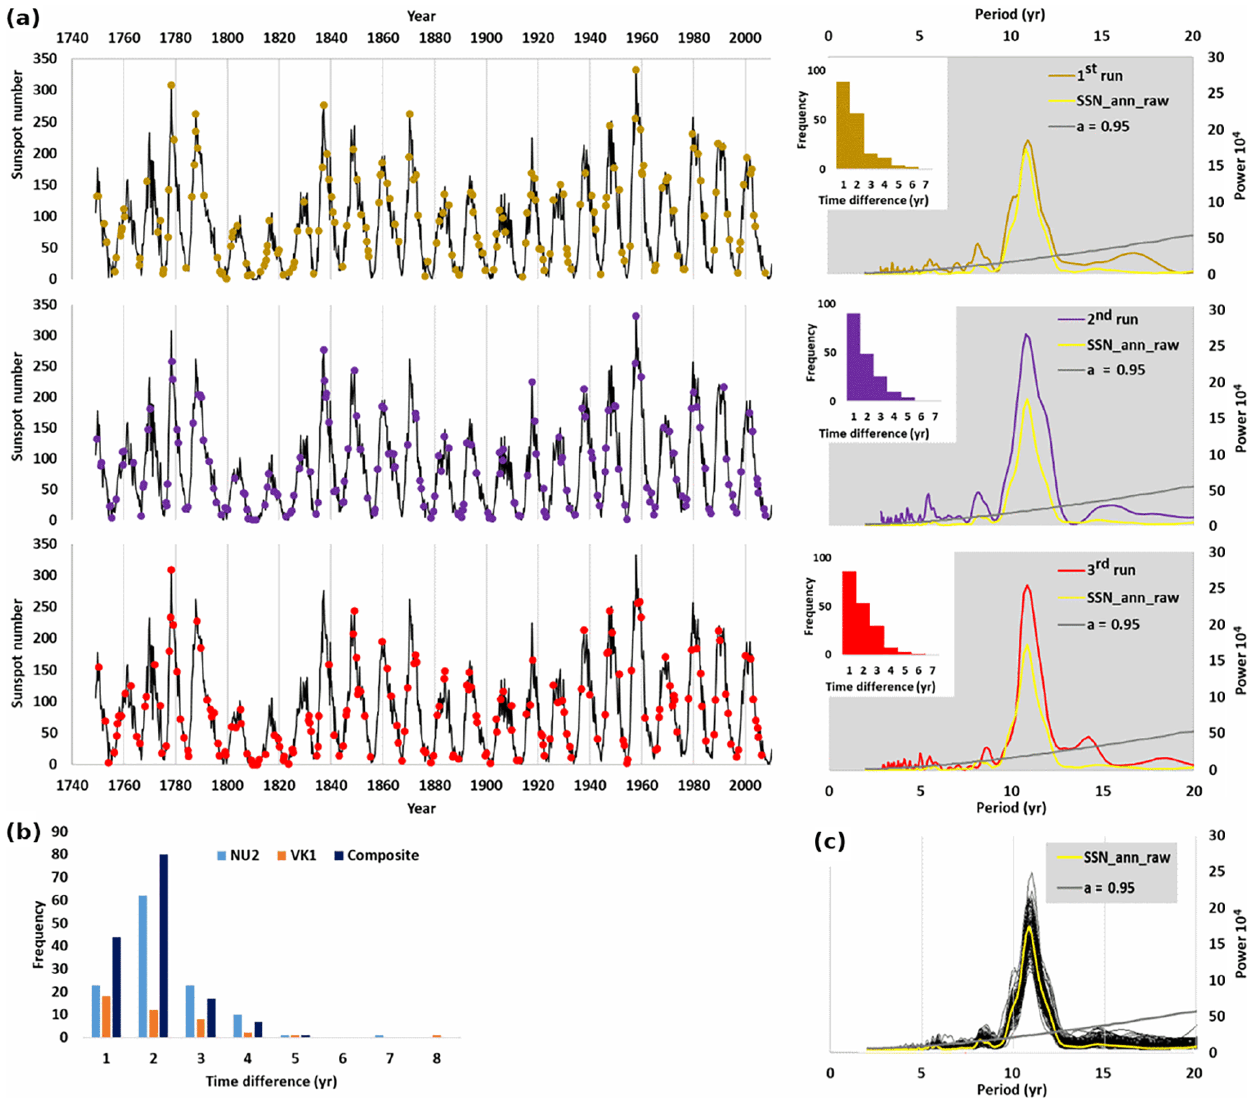
Figure 2. Illustration of the performance and robustness of the resampling protocol. (a) Three examples of the randomly resampled annual mean sunspot numbers (left panels), along with the histograms representing the distribution of time differences between the resampled values, and the rLSPs of the original and the corresponding resampled annual mean sunspot number data (right panels). (b) Histograms of the time differences between the Baradla stable isotope records’ samples. (c) The rLSPs of the original and the 100 randomly resampled annual mean sunspot number data. The rLSP of the annual mean sunspot numbers is in yellow (right column in a and c ). The rLSPs of the randomly resampled un-evenly spaced artificial (sunspot) time series, spline interpolated and annualized from the monthly mean sunspot numbers are in orange, purple and red for the three examples respectively (a) , and in black for all the 100 randomly resampled time series (c) . The bias-corrected 95% chi-squared limit of a fitted AR(1) process for the rLSPs is shown in grey (a, c) .